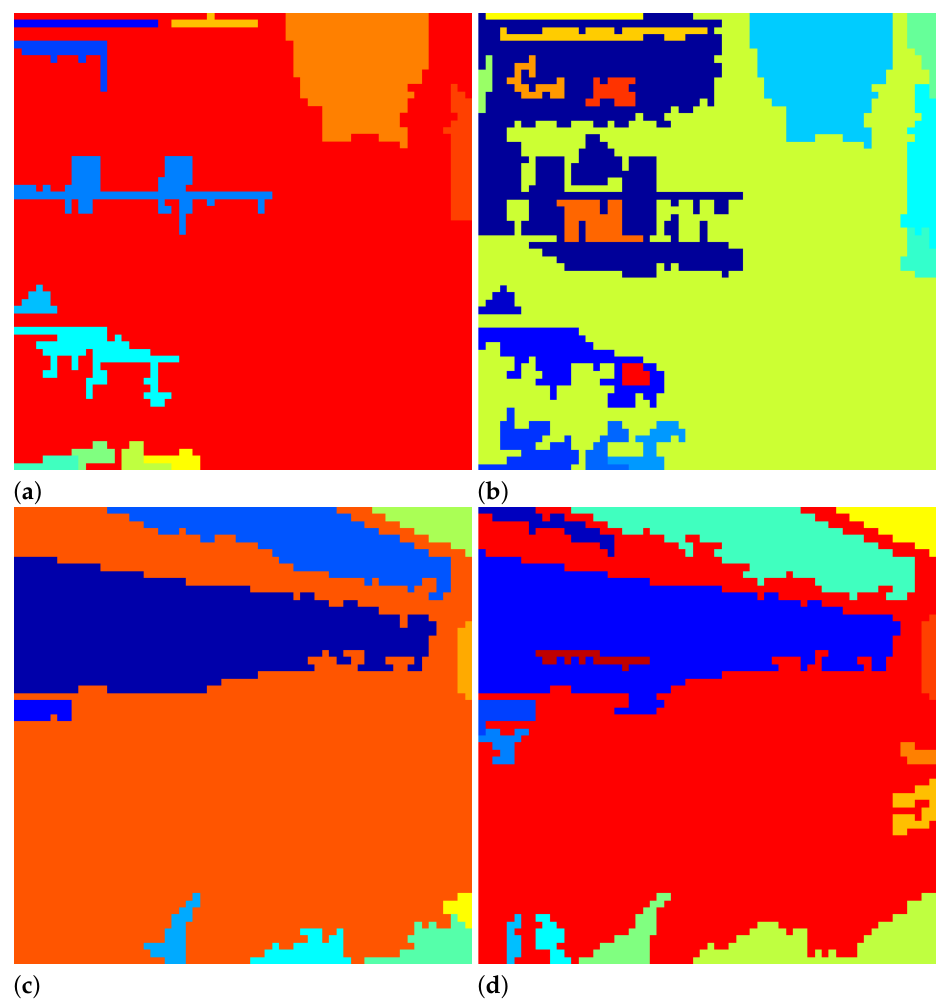
Figure 2. Segments produced by using Otsu’s method ( a , c ) and BR’s method [14] ( b , d ). The first row shows the results for image N11, and the second row shows the results for image N18. The segments are colored for illustration purposes. Refer to Figure 1 for the original